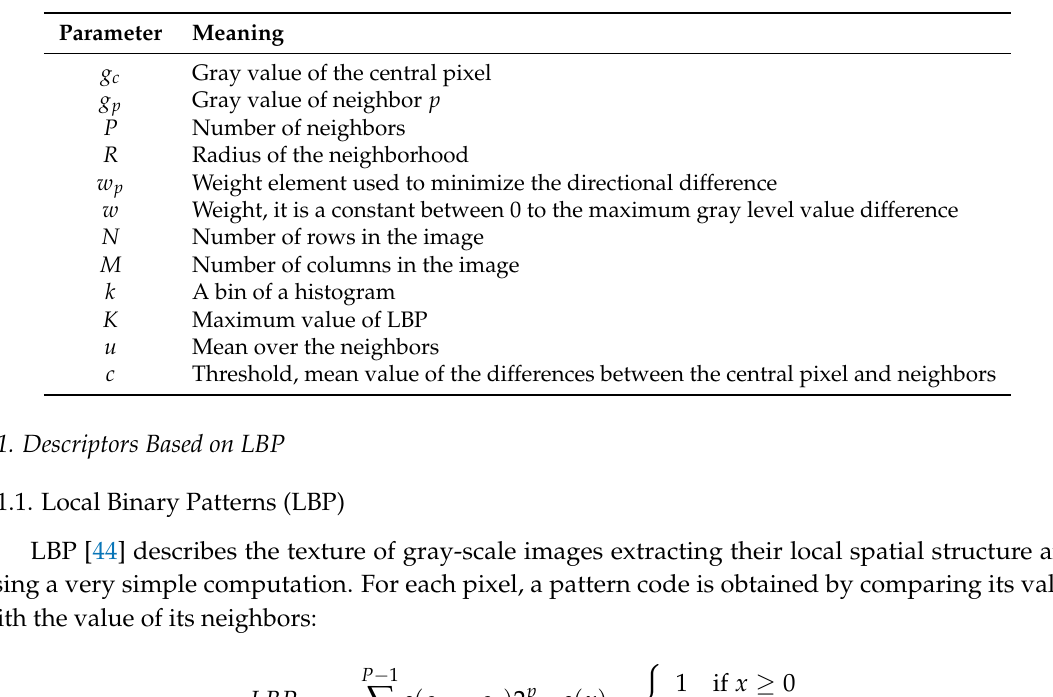
Table 1. Local Binary Patterns (LBP) variants